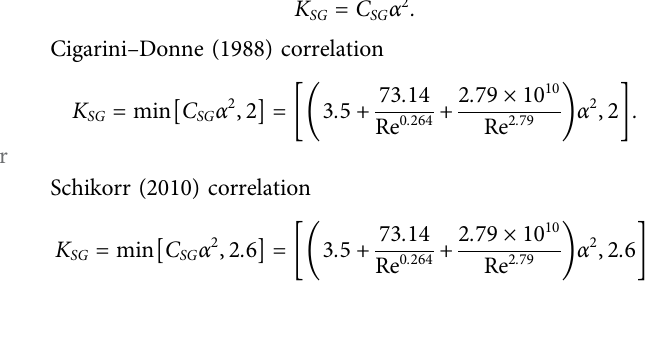
Frontiers in Energy Research |